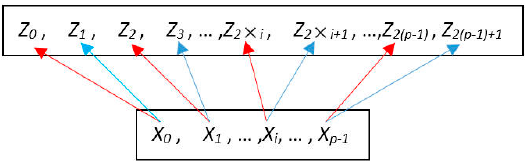
Figure 3. Expanding population X to population Z .